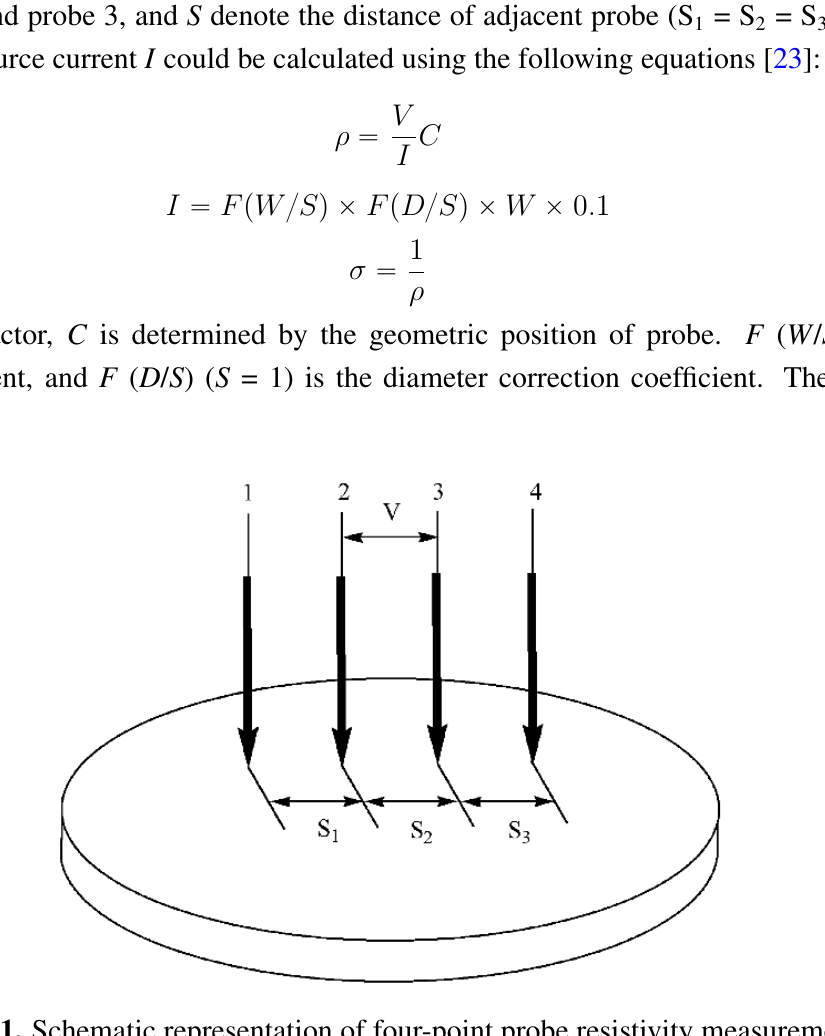
Figure 1. Schematic representation of four-point probe resistivity measurement.